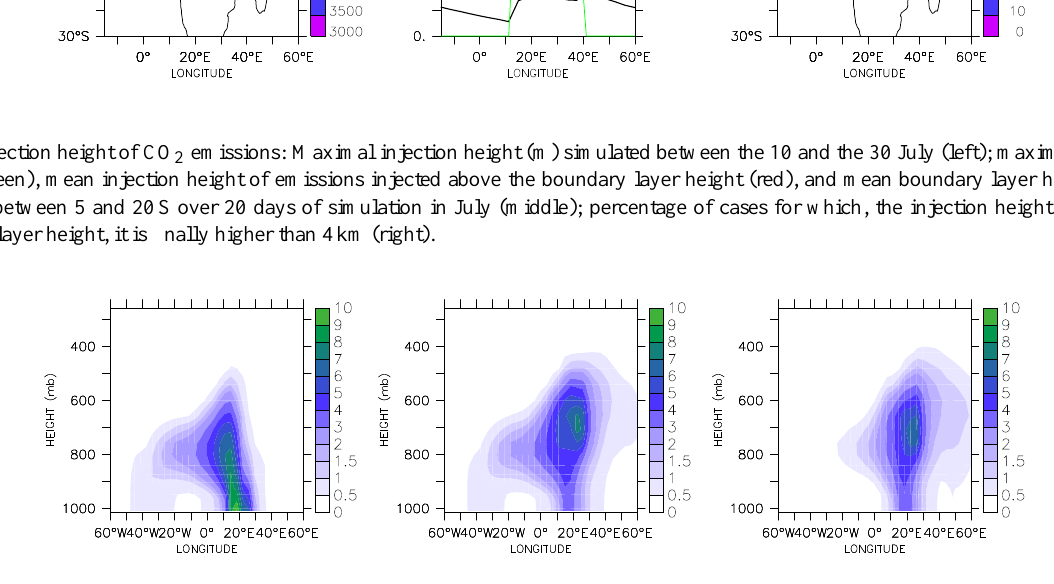
Fig. 9. Vertical distribution of CO 2 mixing ratio in ppmv averaged between 5 and 20S over the 20 last days of July for simulations REF (left), TH (middle) and TH with β = 0 . 1 (right).